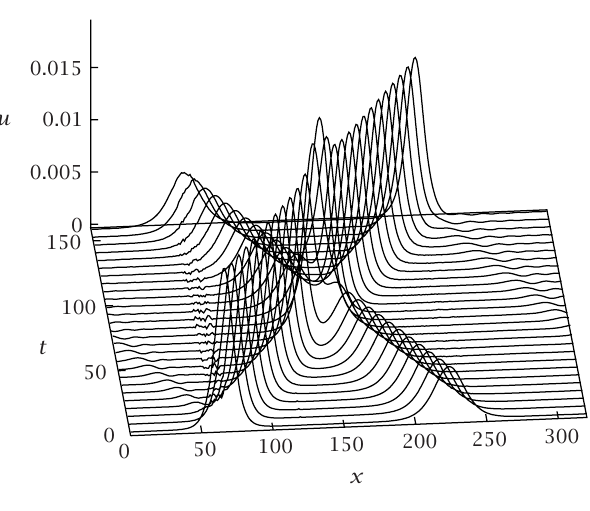
Figure 5.4. Numerical solution with ∆ x = 0 . 1 and ∆ t = 0 .